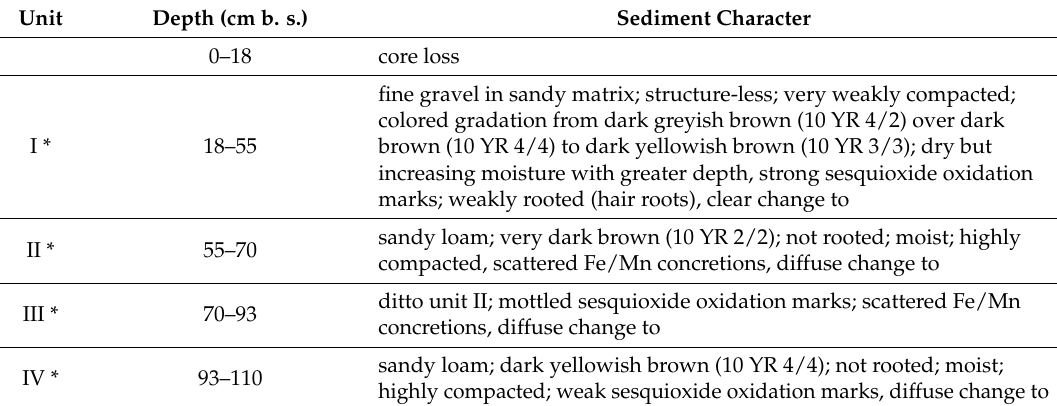
Table 4. Sediment characteristics drilling